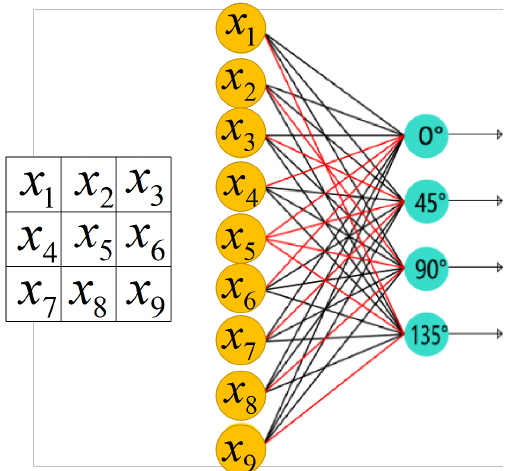
Figure 7. A local orientation neuron mechanism shown as a multi-layer